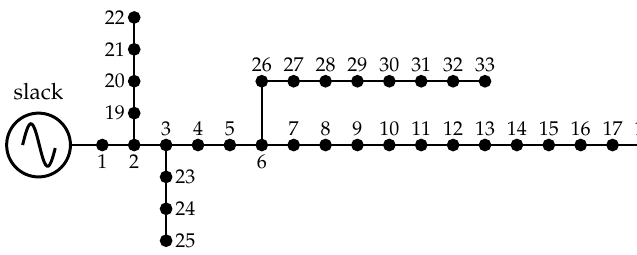
Figure 3. Electrical connection of nodes in the 33 node test feeder.